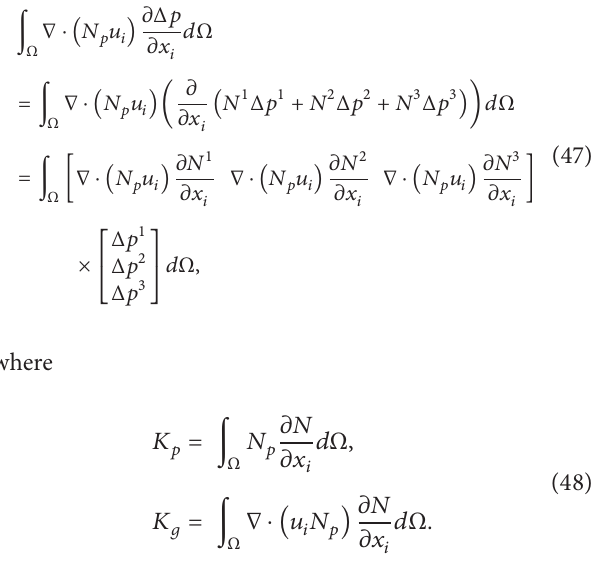
The fifth term on the right side of (40) can be expressed